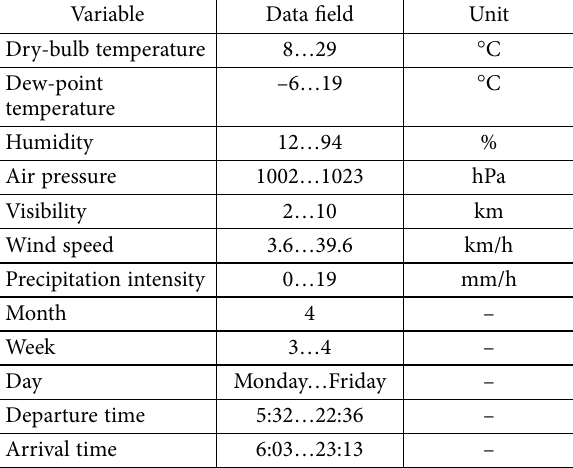
Table 1. Input and output data information of the